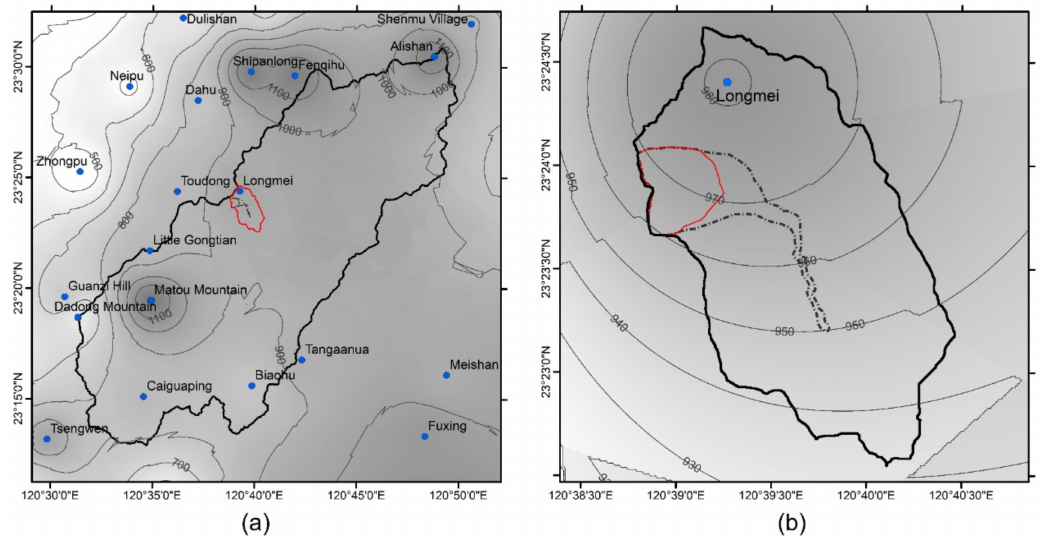
Figure 4. Spatial distribution of maximum daily rainfall in 2009. ( a ) Tsengwen Reservoir Watershed; ( b ) sub-basin where the study area is